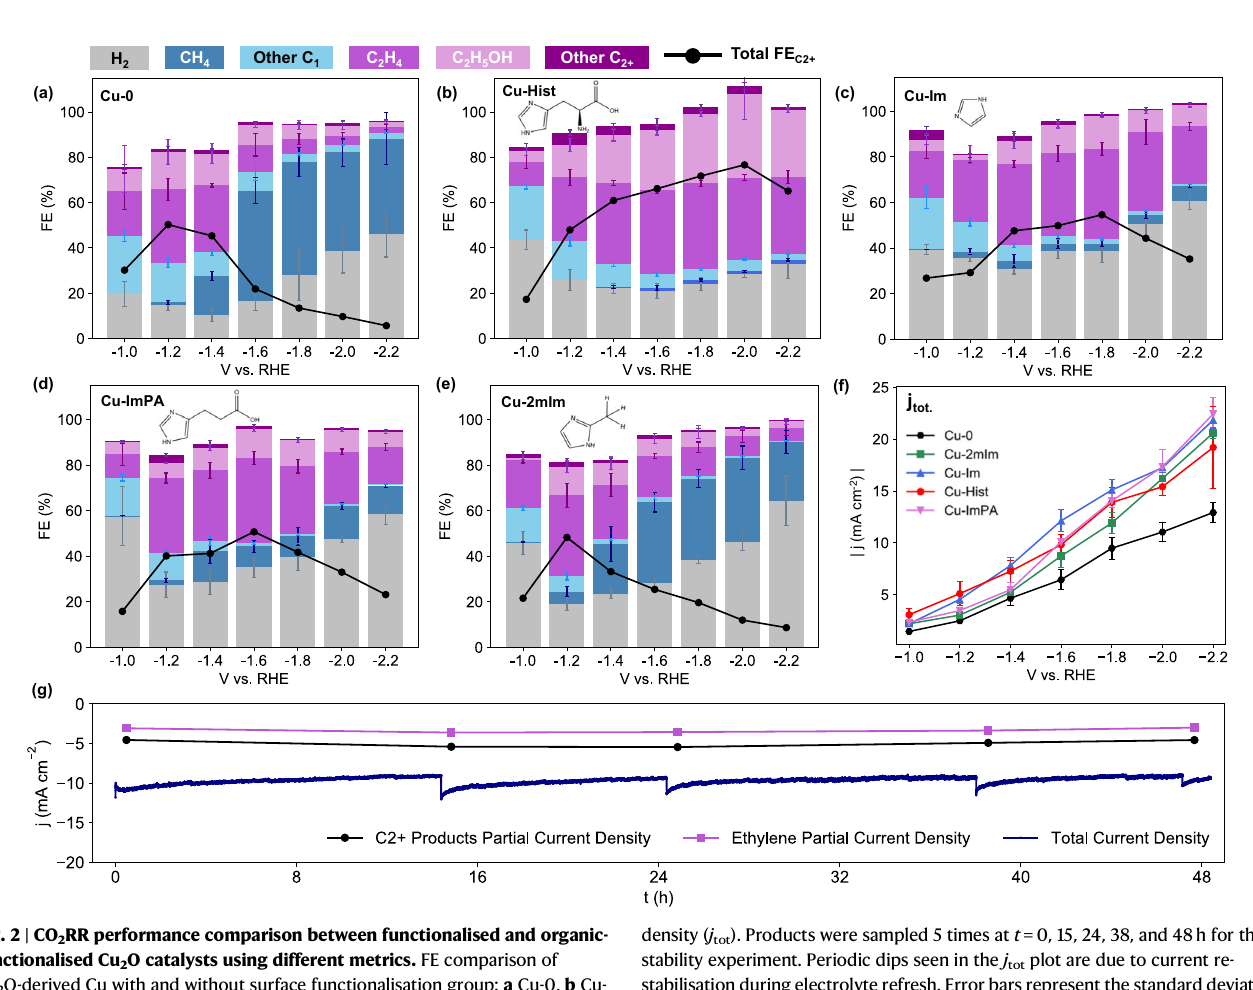
organicfunctionalisations(imidazole,2-methylimidazole,imidazolepropionicacid, arginine,triazole,and glycine) can be introduced by swapping the reagents during synthesis.